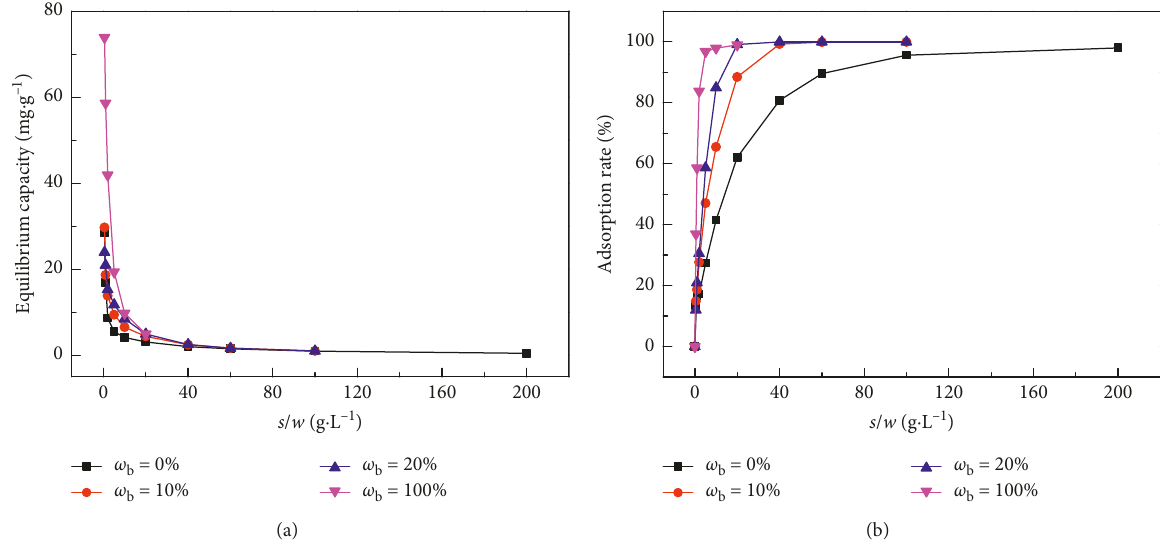
1 ; T 5.5; C i 100mg L 298K; (cid:30) (cid:30) · (cid:30) −